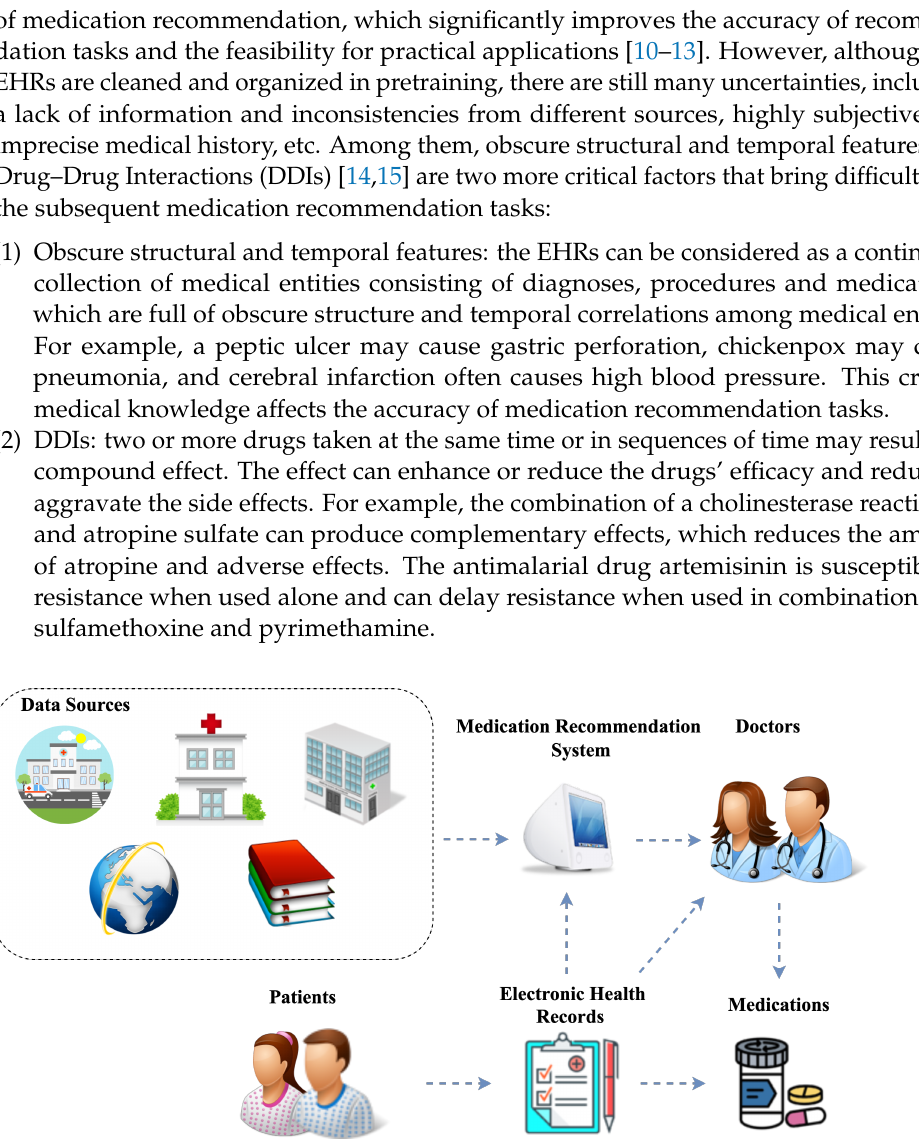
Figure 1. The medication recommendation system is built from multiple data sources that can help physicians develop personalized drug